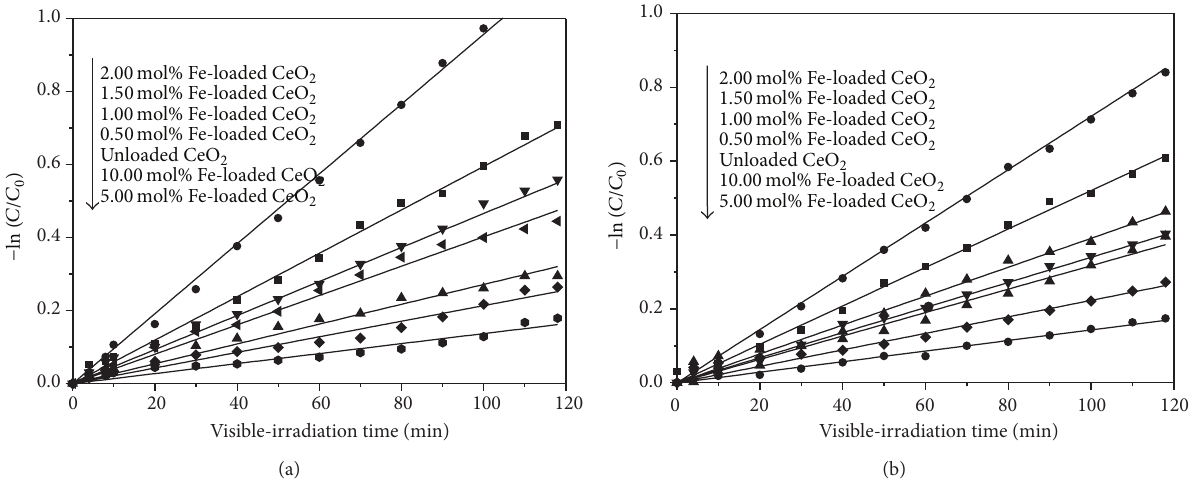
Figure 6: Kinetics plots for linear fitting of data obtained from pseudo first-order reaction for (a) formic acid and (b) oxalic acid degradation under visible-light irradiation.